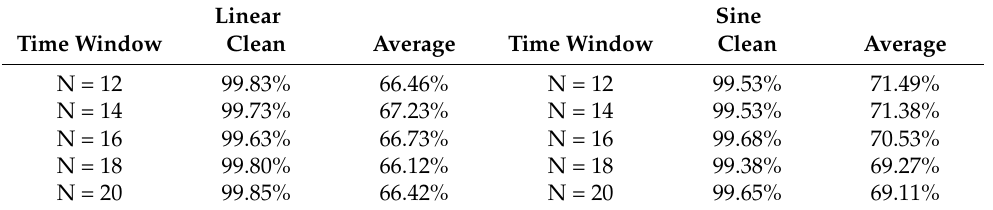
Table 2. Accuracy of different mapping methods under different encoding numbers.